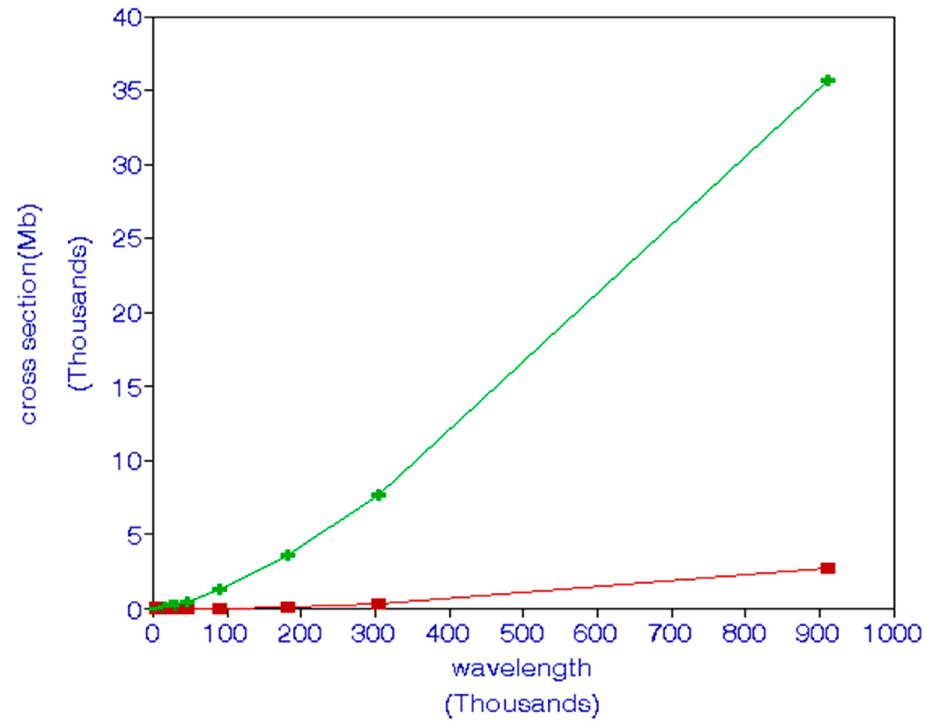
Figure 4. (Color online). The top curve refers to positron cross sections (Mb), while the lower curve refers to electron cross sections (Mb). Wavelengths are in units of Å.